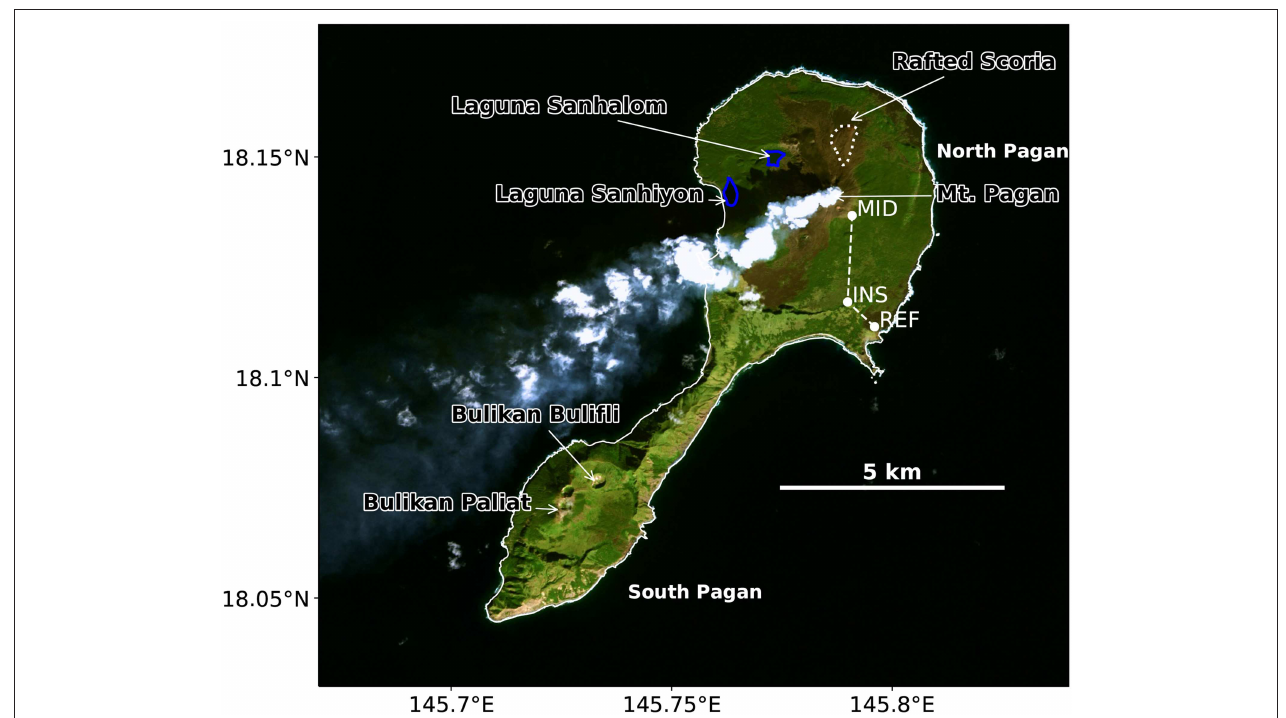
TABLE 1 | Interferograms from Envisat, ALOS, and CSK analyzed during this study. Track Incidence Orbit Dates Interferograms Start End B ⊥